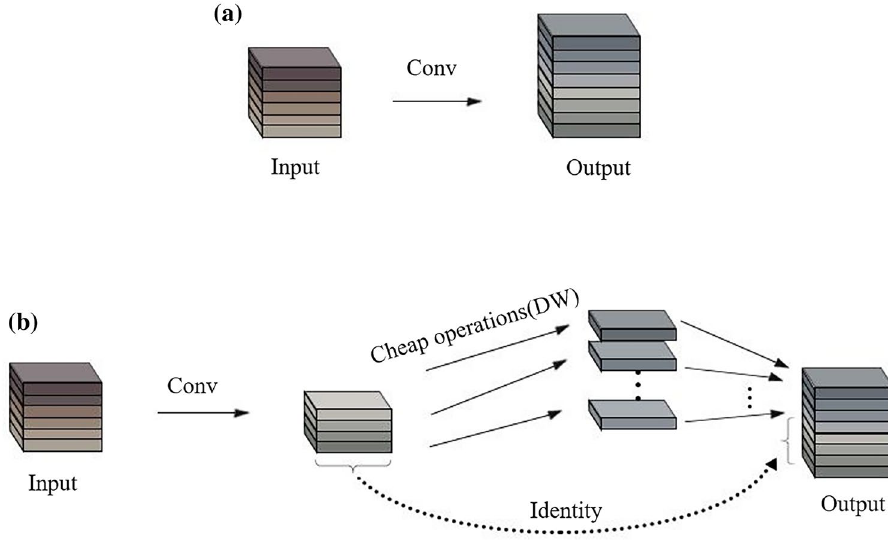
Figure 5. The traditional convolution layer and Ghost module, where ( a ) represents the traditional convolutional layer and ( b ) represents the Ghost